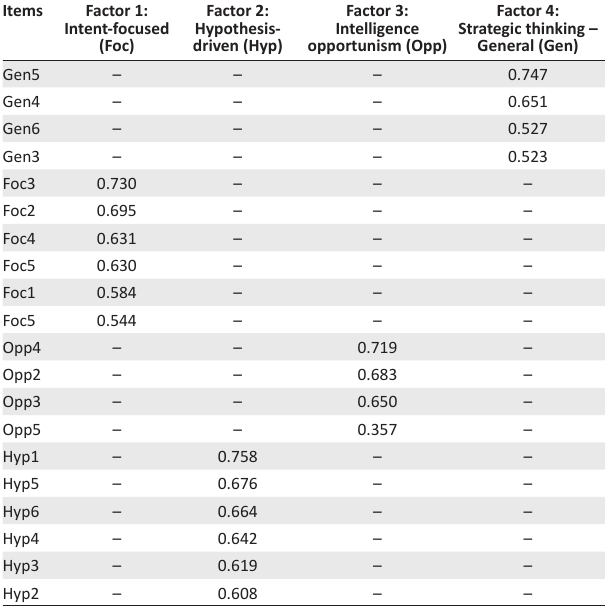
TABLE 4: Results for factor analysis for strategic thinking